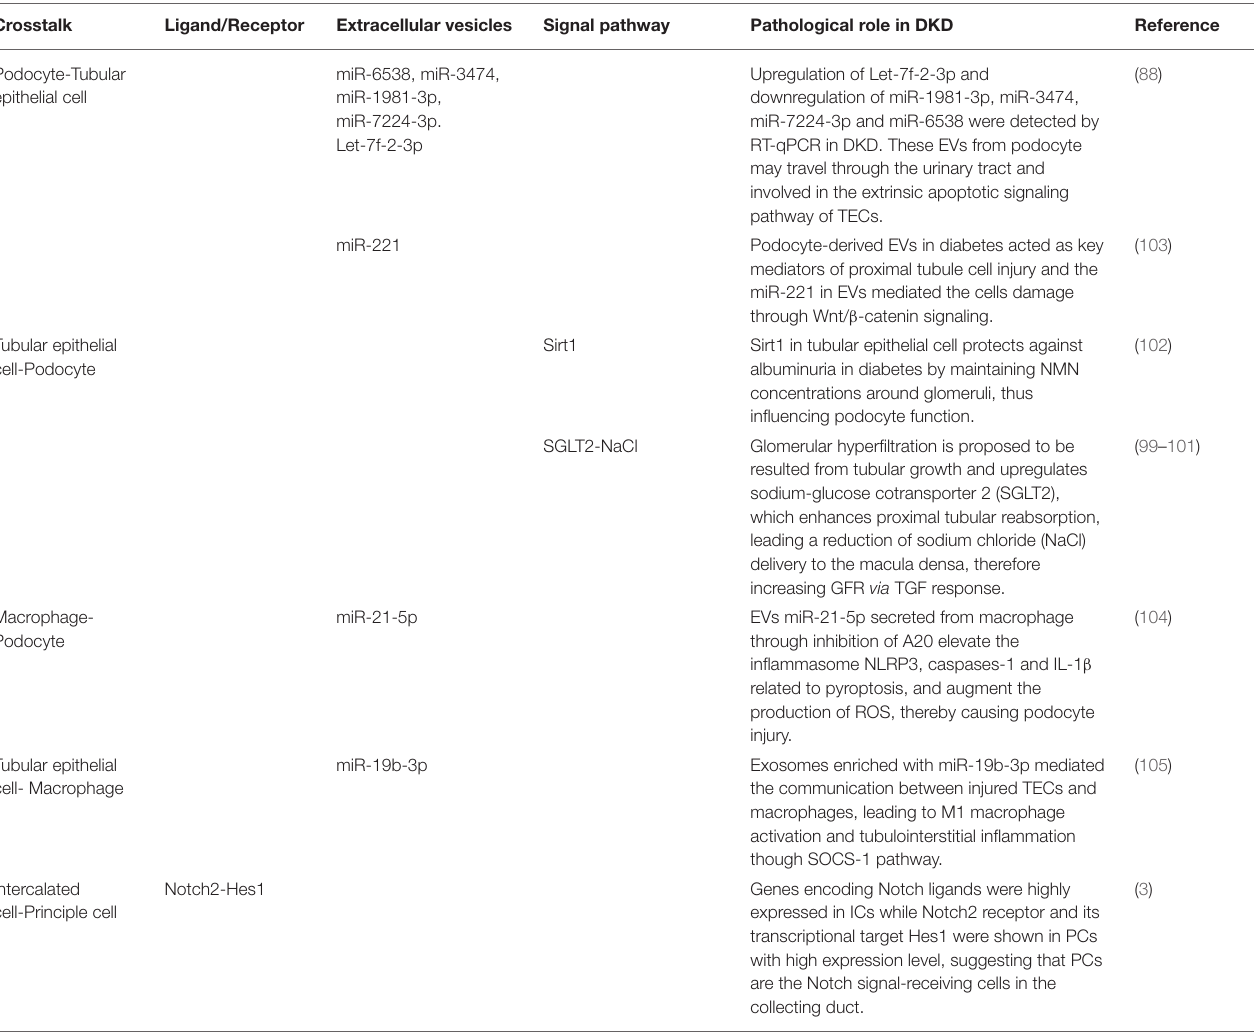
TABLE 2 | Summary of the mediators for extraglomerular crosstalk in